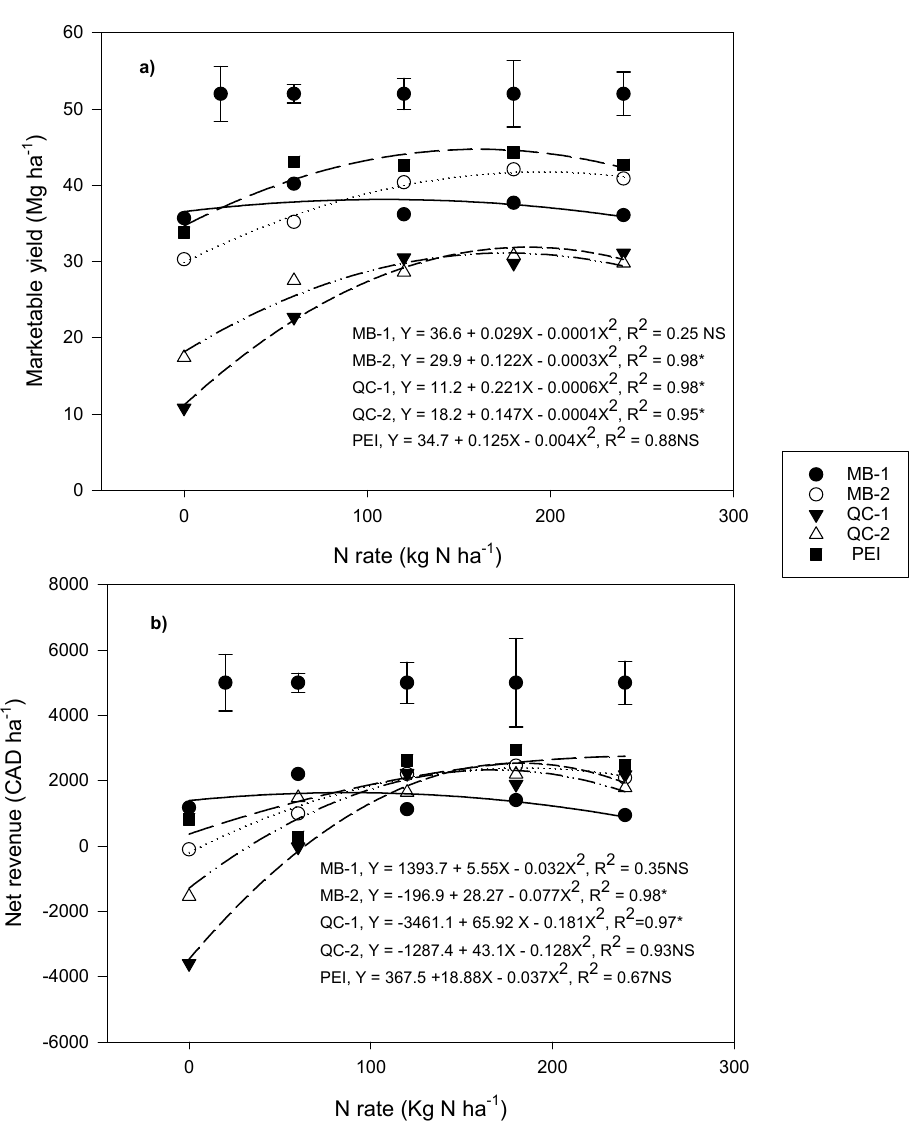
Figure 1. Marketable yield ( a ) and Net revenue (NR) ( b ) overall means fitted with a quadratic model. Vertical bars represent the standard errors of the mean (left to right for MB-1, MB-2, QC-1, QC-2 and PEI). NS, *, not significant and significant at 0.05 probability level.